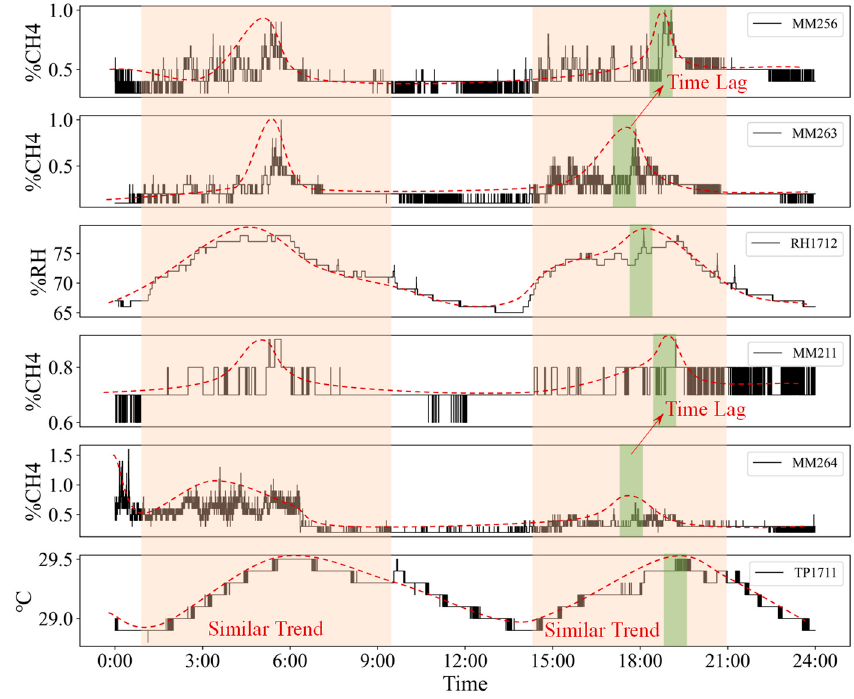
Figure 8. Time series monitoring data of different sensors.